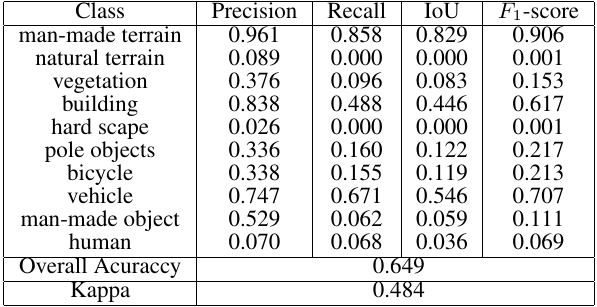
Table 4. Evaluation of the DL-based method against the Table 5. Evaluation of the final output of the fusion against the Testset 2 for all points in that dataset ground truth of the Testset object and human. The resulting classification is shown in the Figure 13 and the results after evaluating this output against the ground truth are provided in Table 5. When compared to the results of both methods individually (Tables 4 and 2), significant improvement by obtaining the fusion is evident.